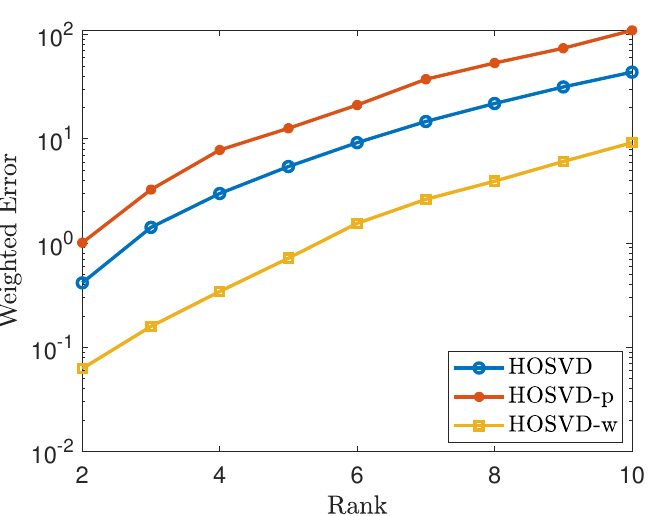
Figure 5. Tensor of size 100 × 100 × 100 using the non-uniform sampling pattern and with the SV-rank as the input rank: plots the errors of the form